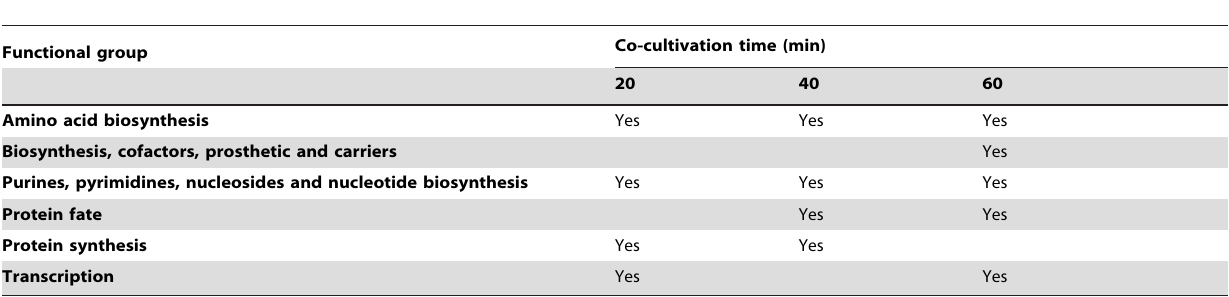
T = 90min. The results indicated that meningococcal surface expression, and therefore potential vaccine candidacy, of NMB0390 was induced by co-incubation with human blood. Table 4. Significantly enriched* TIGR functional groups of differentially expressed meningococcal genes in response to blood co- cultivation.